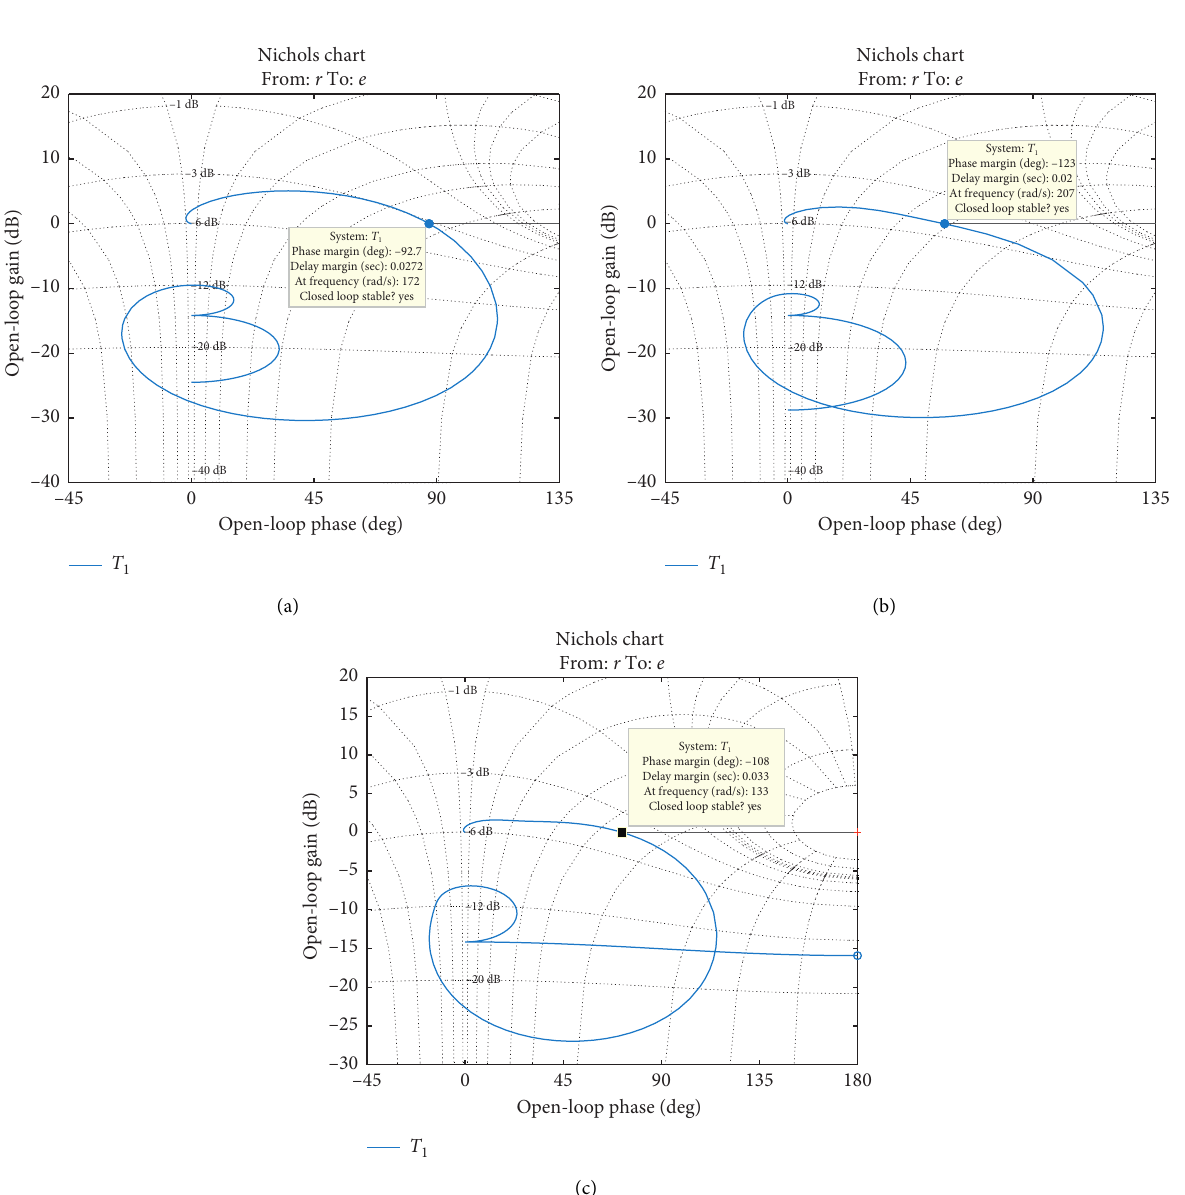
Figure 6: Nichols plots of EPS with (a) controller 1, (b) controller 2, and (c) controller